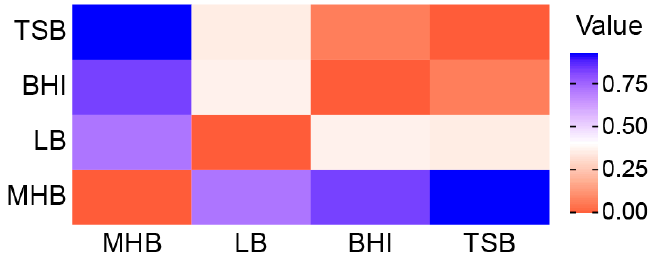
Figure 2. Media-dependent staph volatilome variation represented as a dissimilarity matrix using Morisita–Horn differences calculated using relative abundances of volatile chemical classes.